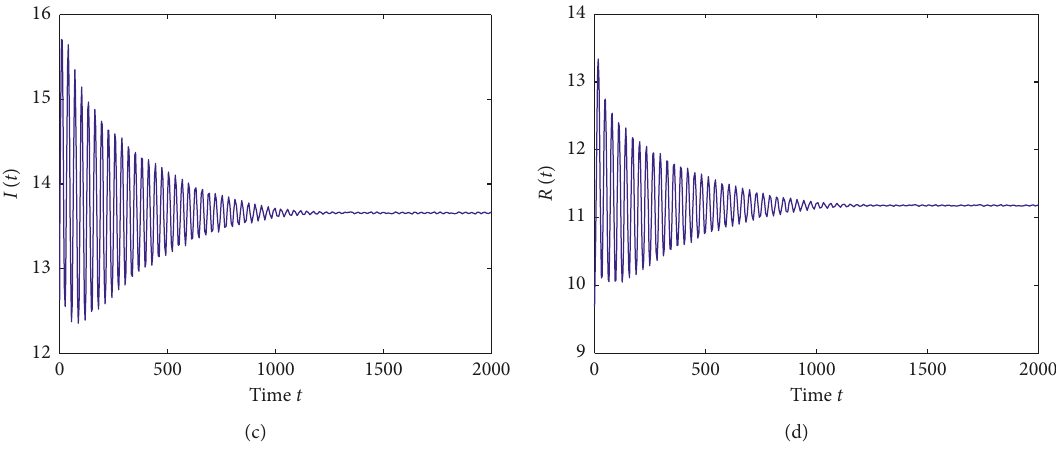
Figure 6: Waveform plots of system (65) with τ